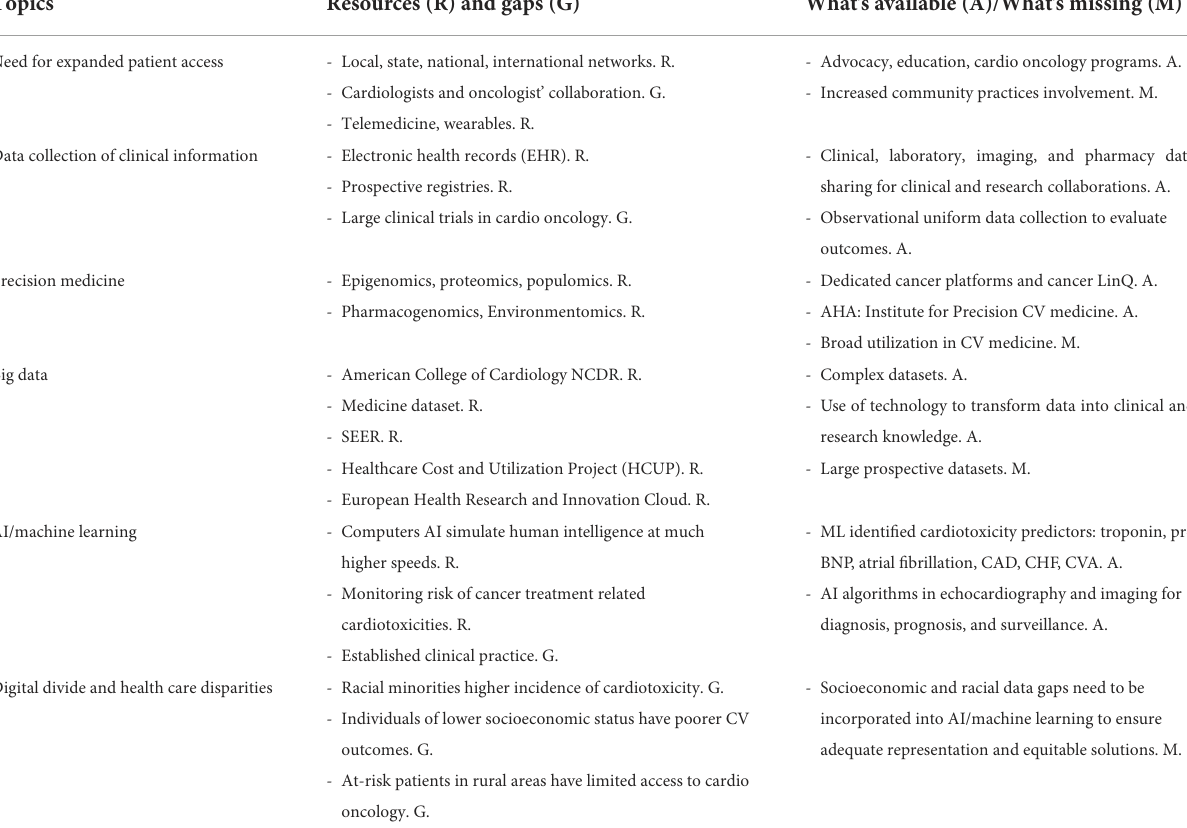
TABLE 1 Summary of sources of data collection, AI/precision medicine and digital